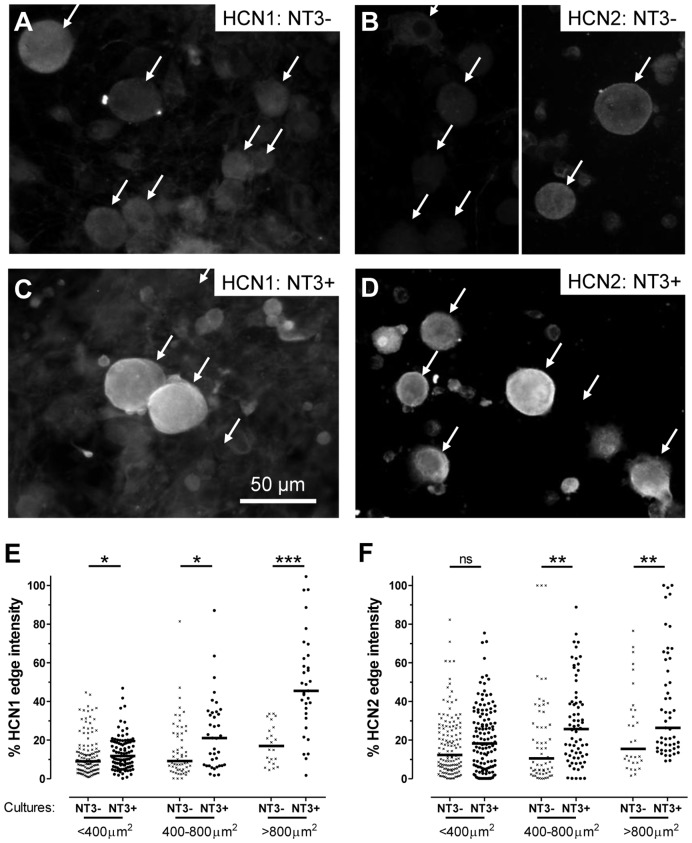
HCN1 and HCN2 dependence on NT3.
A to D: DRG neurons cultured for 2 days in absence (A and B) or presence (C and D) of NT3 (40 ng/ml). HCN1 (A and C) and HCN2 (B and D) immunofluorescence examples are shown. Immunostaining for both was much reduced in the absence of NT3. Arrows in A and B show neurons visible under interference contrast; many were so weakly stained they were not/weakly visible under fluorescence. Note that in B, the left hand image includes smaller neurons; the right image includes a medium-sized and a large neuron. In C and D (with NT3), staining was stronger at the cell perimeter of medium to large neurons for both HCN1 and HCN2. Some smaller neurons showed elevated HCN2 staining (D). E and F: Quantitation of the effect of NT3 (40 ng/ml) on HCN1 and HCN2 edge staining after 2 days in culture. Medians for HCN1 and HCN2-edge immunostaining were both significantly greater (Mann Whitney test) for medium and large neurons in the presence of NT3. For HCN1 only, there was also a significant elevation in edge staining in small neurons with NT3. * P<0.05; **P<0.01, ***P<0.001, ****P<0.0001.